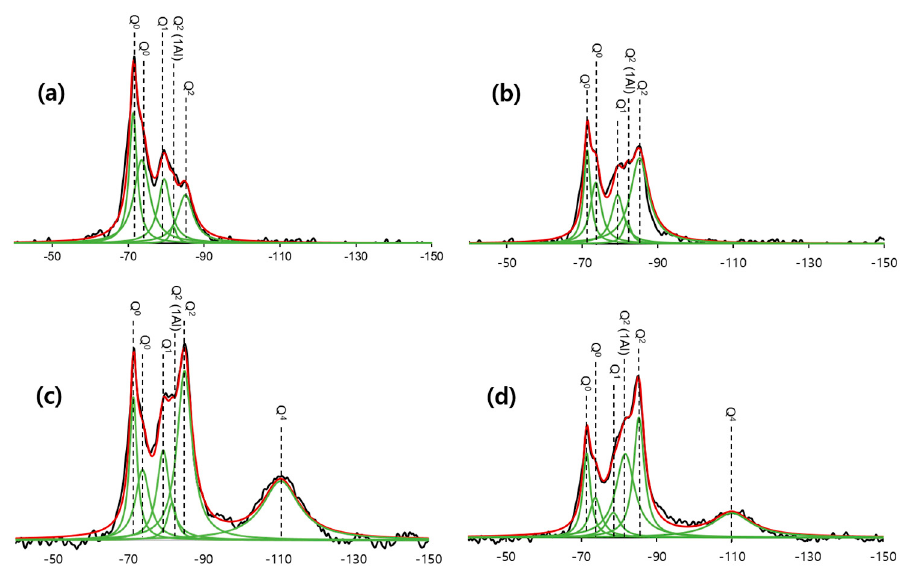
Figure 6. 29 Si magic angle spinning nuclear magnetic resonance ( 29 Si MAS NMR) spectra and deconvolutions of the 28-day specimens: ( a ) C_28, ( b ) C_28_HT, ( c ) CS_28, ( d ) CS_28_HT) Table 3. Deconvolution results for 29 Si MAS NMR spectra, wt.% [34].